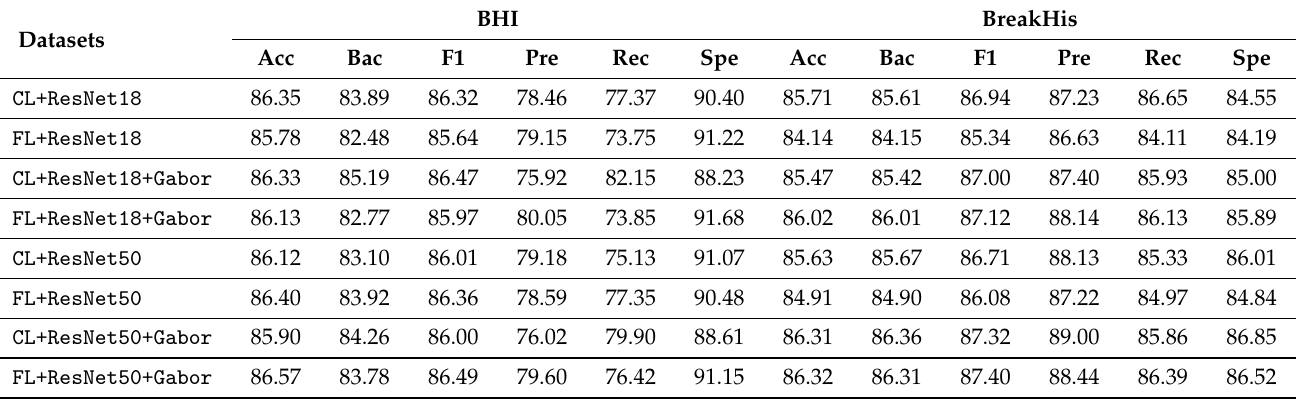
Table 4. Patch-wise result comparison on the test datasets with the CL and the FL global